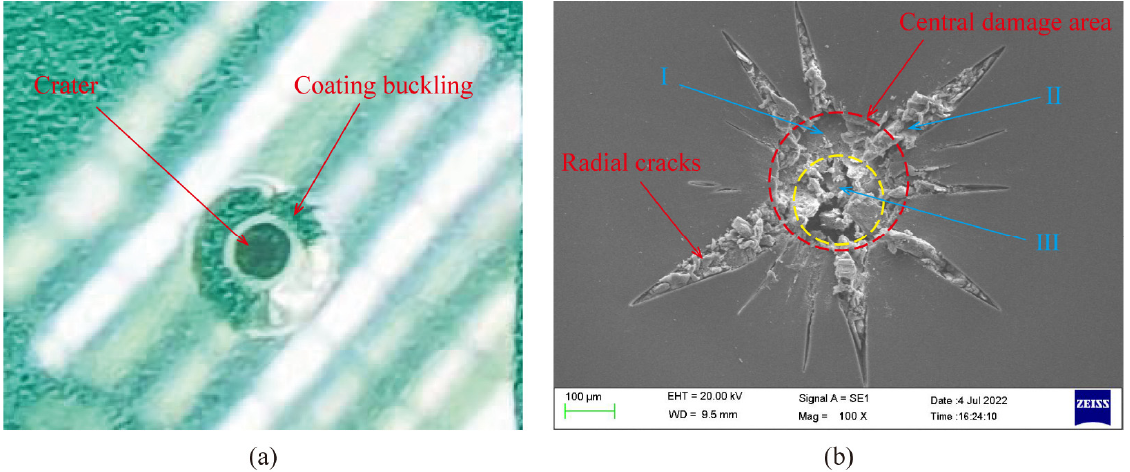
Figure 4. ( a ) The appearance of the sample after impacting. ( b ) SEM photograph of the sample. The chemical compositions of each paint film determined by SEM are listed in Table 5.